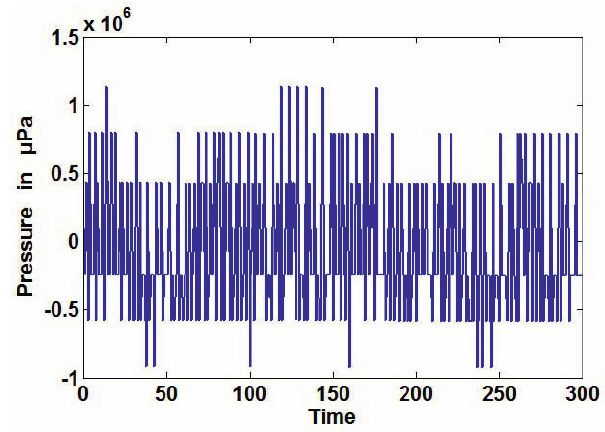
Figure 6. Noise signal.